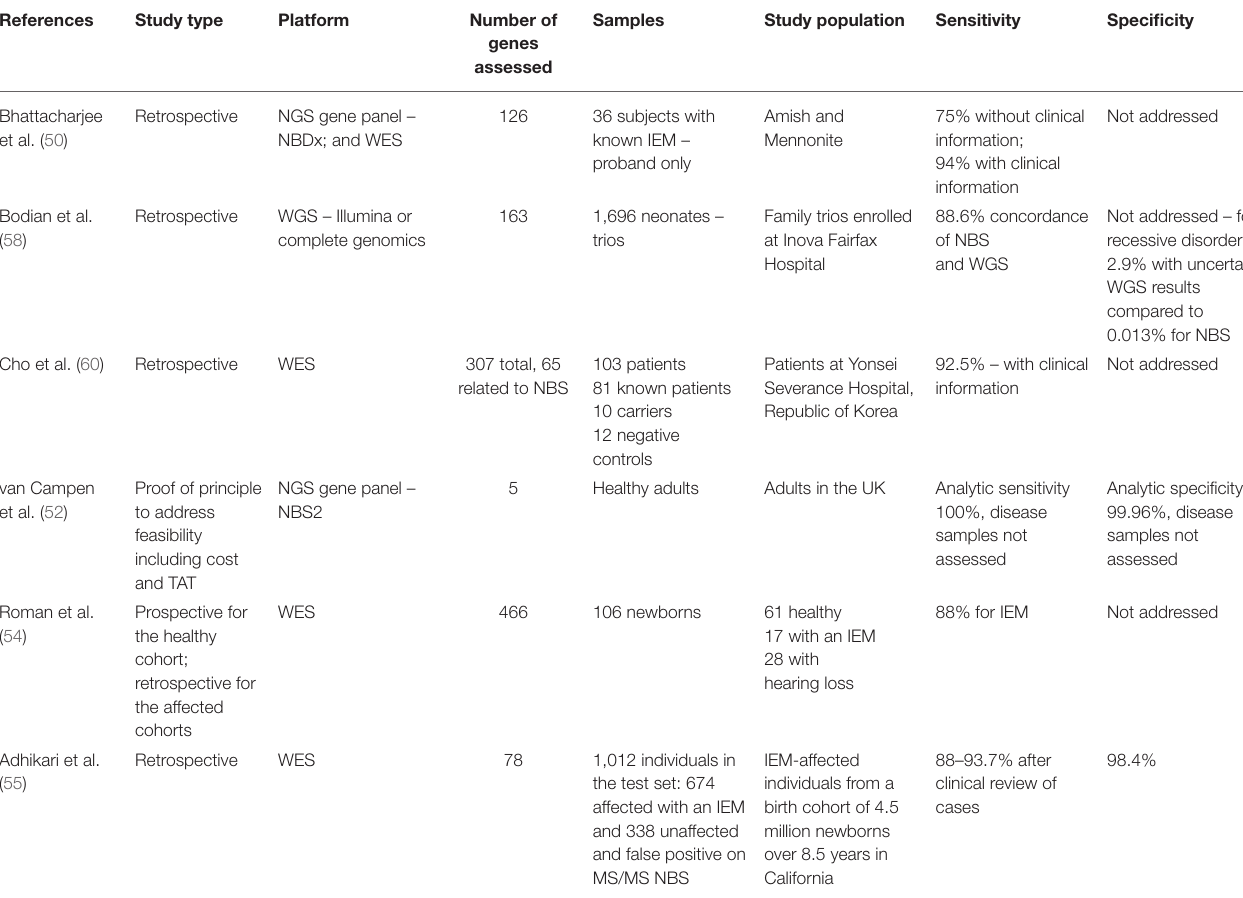
TABLE 2 | Summary of studies on next-generation sequencing for newborn